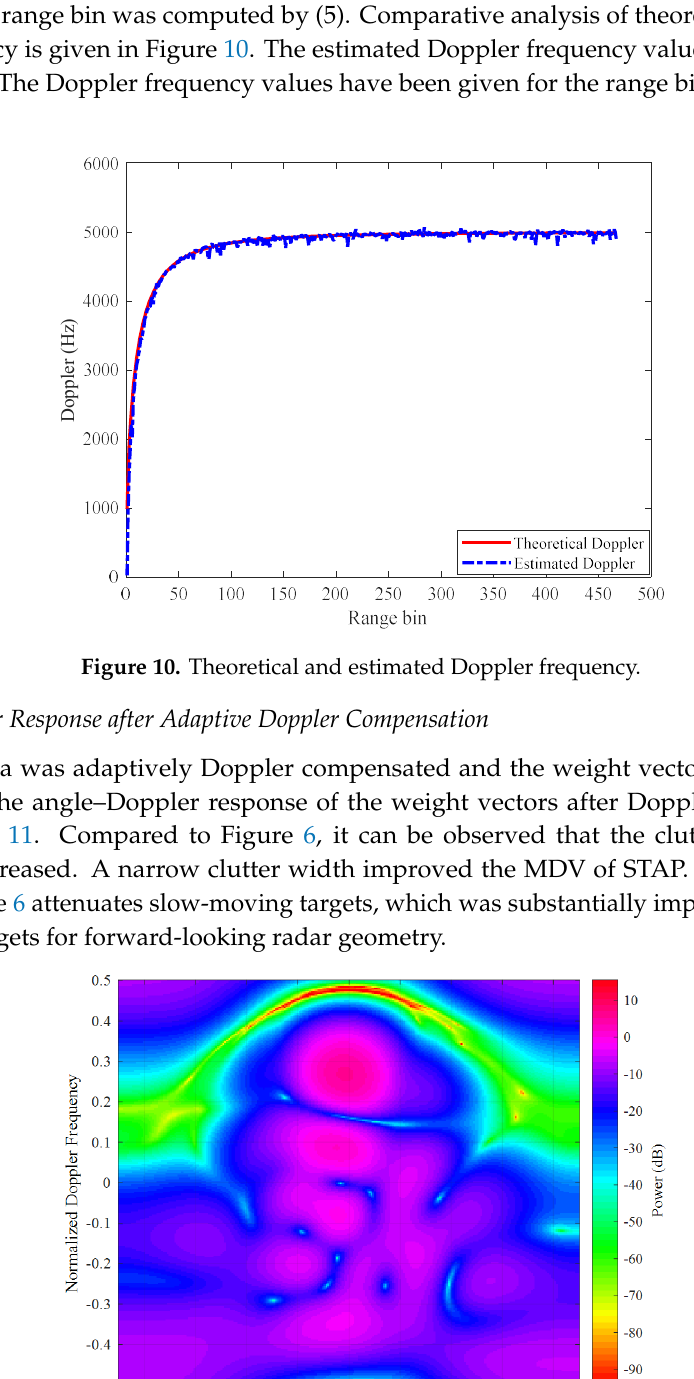
Figure 9. Range–Doppler map of raw data.